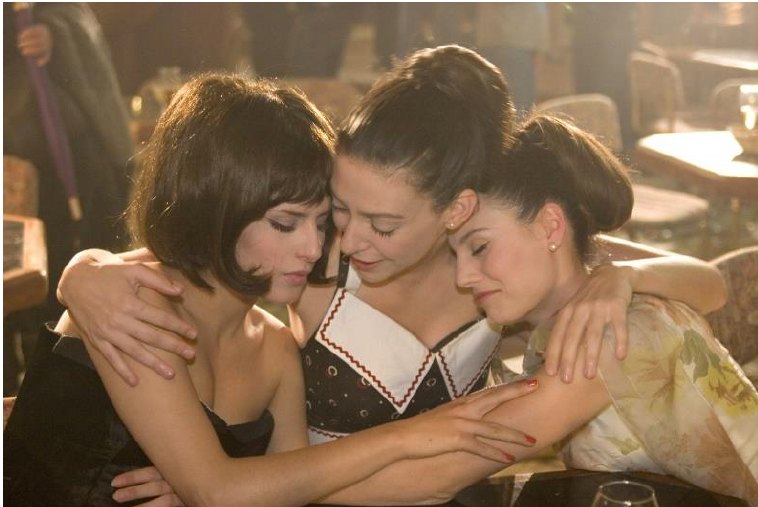
Figure 2. Dina Zvi-Riklis, Three Mothers ( Shalosh Imaot , 2006), The Three Sisters as Young Women. Credit: Yoni Menachem. Used with the director’s permission.